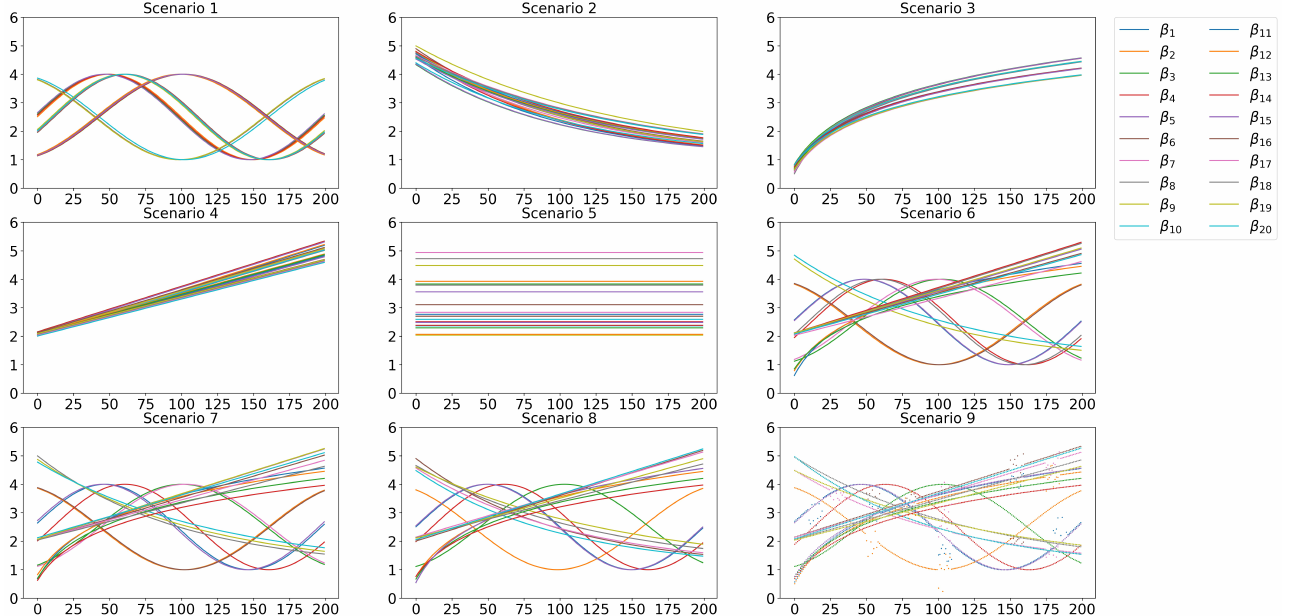
Figure A2. Nonzero coefficients of all subjects under Scenarios 1–9. The x -axis represents the subjects, and the y -axis represents the coefficient